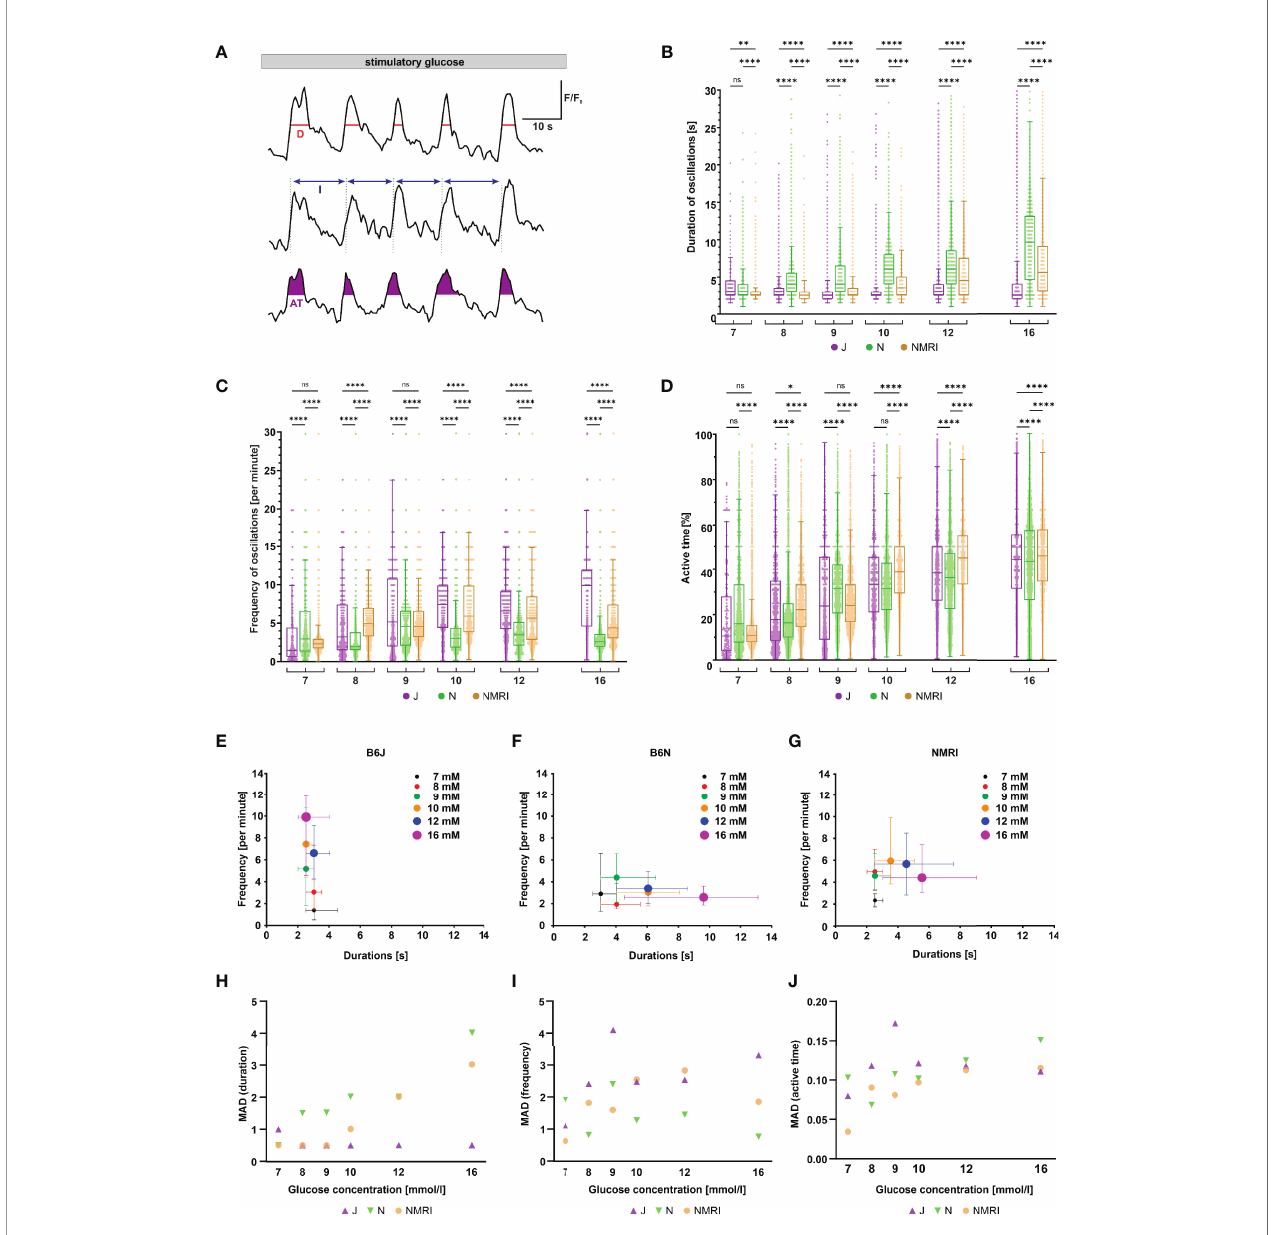
FIGURE 3 | Duration, frequency, and active time of fast oscillations during the plateau phase of beta cell response to glucose in C57BL/6J, C57BL/6N, and NMRI mice. (A) Schematic representation of analyzed parameters: oscillation duration (D) , frequency calculated from burst period (I), and active time (AT). Shown are three typical beta cells during the plateau phase of a response to 10 mM glucose. (B) Duration of oscillations in the three strains. C57BL/6J: median 3.0, 3.0, 2.5, 2.5, 3.0, and 2.5 s, C57BL/6N: 3.0, 4.0, 4.0, 6.1, 6.1, and 9.6 s, NMRI 2.5, 2.5, 2.5, 3.5, 4.5, and 5.5 s) in 7-, 8-, 9-, 10-, 12-, and 16-mM glucose, respectively. (C) Frequency of oscillations. C57BL/6J: median (1.5, 3.2, 5.2, 7.4, 6.6, and 9.6 min -1 , C57BL/6N: 3.0, 1.9, 4.6, 3.0, 3.5, and 2.6 min -1 , and NMRI: 2.3, 5.0, 4.6, 5.9, 5.7, and 4.4 min -1 in 7-, 8-, 9-, 10-, 12-, and 16-mM glucose, respectively. (D) Percentage of active time. C57BL/6J: median 10.6, 17.8, 23.8, 33.3, 38.5, and 44.4%, C57BL/6N: median 16.0, 16.4, 31.6, 31.6, 36.4, and 43.6%, and NMRI: median 10.9, 22.2, 24.0, 38.9, 45.0, and 46.2% in 7-, 8-, 9-, 10-, 12-, and 16-mM glucose, respectively. (E) Oscillation durations as a function of respective frequency for B6J. (F) Oscillation durations as a function of respective frequency for B6N. (G) Oscillation durations as a function of respective frequency for NMRI. (H) MAD of oscillation durations. C57BL/6J: median 1.0, 0.5, 0.5, 0.5, 0.5, and 0.5 s, C57BL/6N: median 0.5, 1.5, 1.5, 2.0, 2.0, and 4.0 s, NMRI: 0.5, 0.5, 0.5, 1.0, 2.0, and 3.0 s in 7-, 8-, 9-, 10-, 12-, and 16-mM glucose, respectively. (I) MAD of oscillation frequency. C57BL/6J: median 1.1, 2.4, 4.1, 2.5, 2.5, and 3.3 min -1 , C57BL/6N: median 1.9, 0.8, 2.4, 1.3, 1.4, and 0.8 min -1 , and NMRI: median 0.6, 1.8, 1.6, 2.5, 2.8, and 1.9 min -1 in 7-, 8-, 9-, 10-, 12-, and 16-mM glucose, respectively. (J) MAD of percent of active time. C57BL/6J: median 8.0, 11.8, 17.2, 12.1, 11.8, and 11.1%, C57BL/6N: 10.3, 6.8, 10.7, 10.2, 12.5, and 15.1%, and NMRI: median 3.4, 9.0, 8.1, 9.7, 11.2, and 11.5 in 7-, 8-, 9-, 10-, 12-, and 16-mM glucose, respectively. Pooled data (coded as C57BL/6JC57BL/ 6NNMRI) from the following number of cells/islets/pancreas preparations: 57/6/5| 325/11/6| 292/11/6 (7 mM glucose), 96/10/7| 671/8/5 381/10/5 (8 mM glucose), 246/ 8/7| 684/9/6| 574/10/6 (9 mM glucose), 250/8/5| 531/9/5| 677/9/6 (10 mM glucose), 322/10/7| 456/9/4| 310/7/5 (12 mM glucose), and 256/9/5| 414/7/5| 458/8/6 (16 mM glucose). Where present, the following symbols in indicate p-values: *p < 0.05, **p < 0.01, ***p < 0.001, ****p < 0.0001; ns, not signi fi